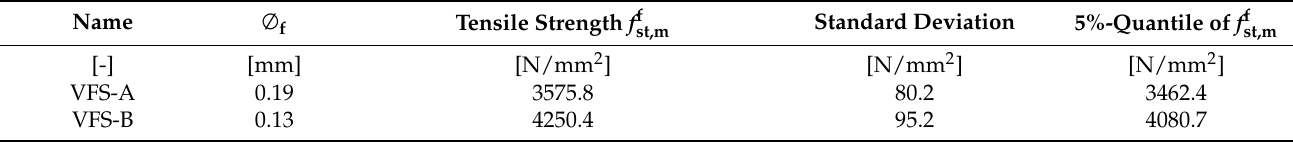
Table 2. Characteristic values for the theoretical stress–strain relationship of high-strength micro steel fibres.